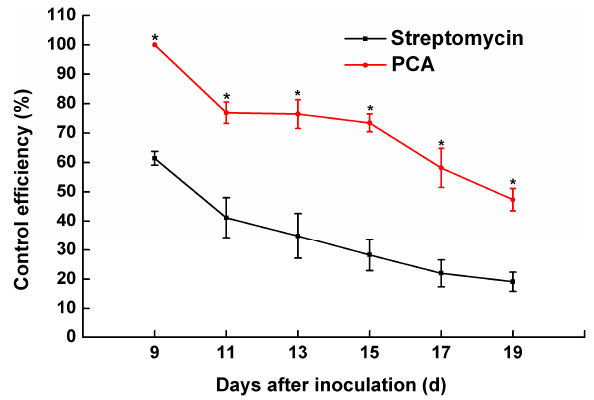
Figure 9. The control effect of PCA on tobacco inoculated with R. solanacearum . The bars indicate the standard error of the mean of three replicates. * indicates a significant difference between treatments (independent-samples T test, p < 0.05).